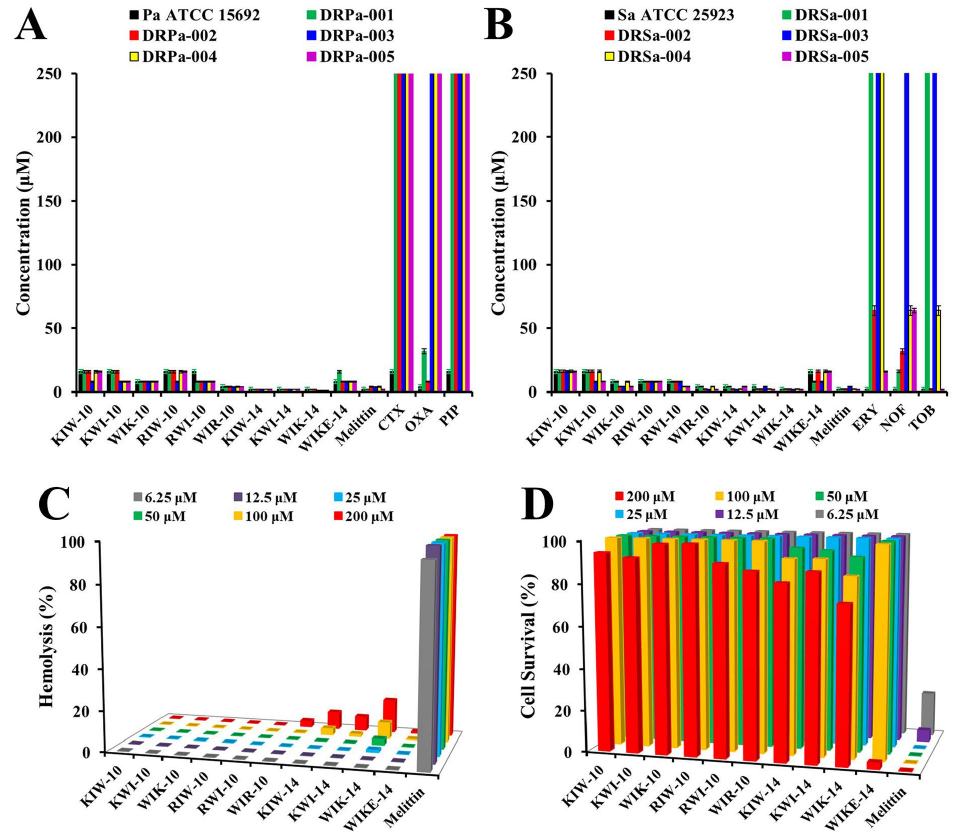
Figure 2. Antibacterial ( A , B ), hemolytic ( C ), and cytotoxic ( D ) effects of synthetic peptides. ( A , B ) MICs of peptides were evaluated against drug-susceptible bacteria ( P. aeruginosa ATCC145692 and S. aureus ATCC25923) and drug-resistant bacteria (DRPa-001~005 and DRSa-001~005), compared to cefotaxime (CTX), oxacillin (OXA), piperacillin (PIP), erythromycin (ERY), norfloxacin (NOF), and tobramycin (TOB). ( C ) Hemolysis and cytotoxicity ( D ) of peptides was investigated in rat erythrocytes and HaCaT cells, respectively.